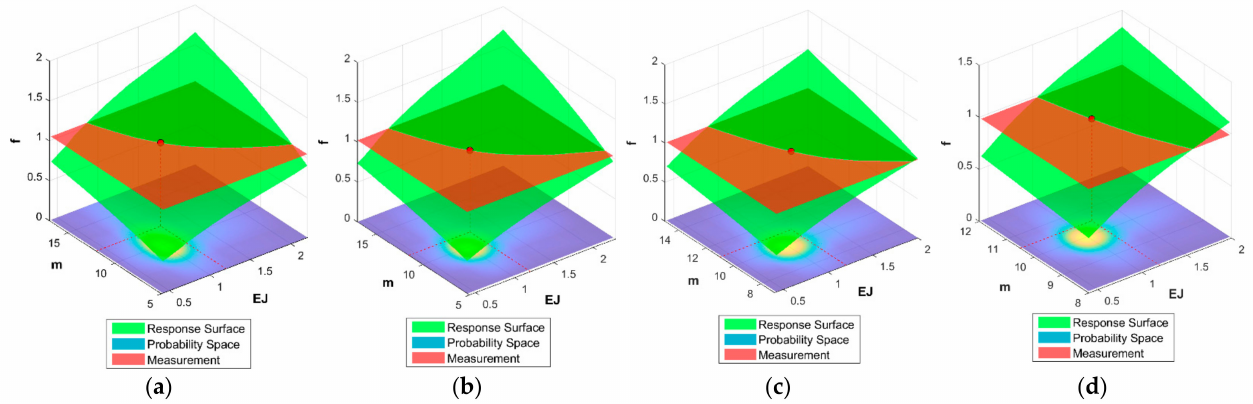
Figure 12. Comparison of response surfaces with different sensitivities for the parameters—SDOF: ( a ) COV m = 0.05, ( b ) COV m = 0.1, ( c ) COV m = 0.15 and ( d ) COV m = 0.2.